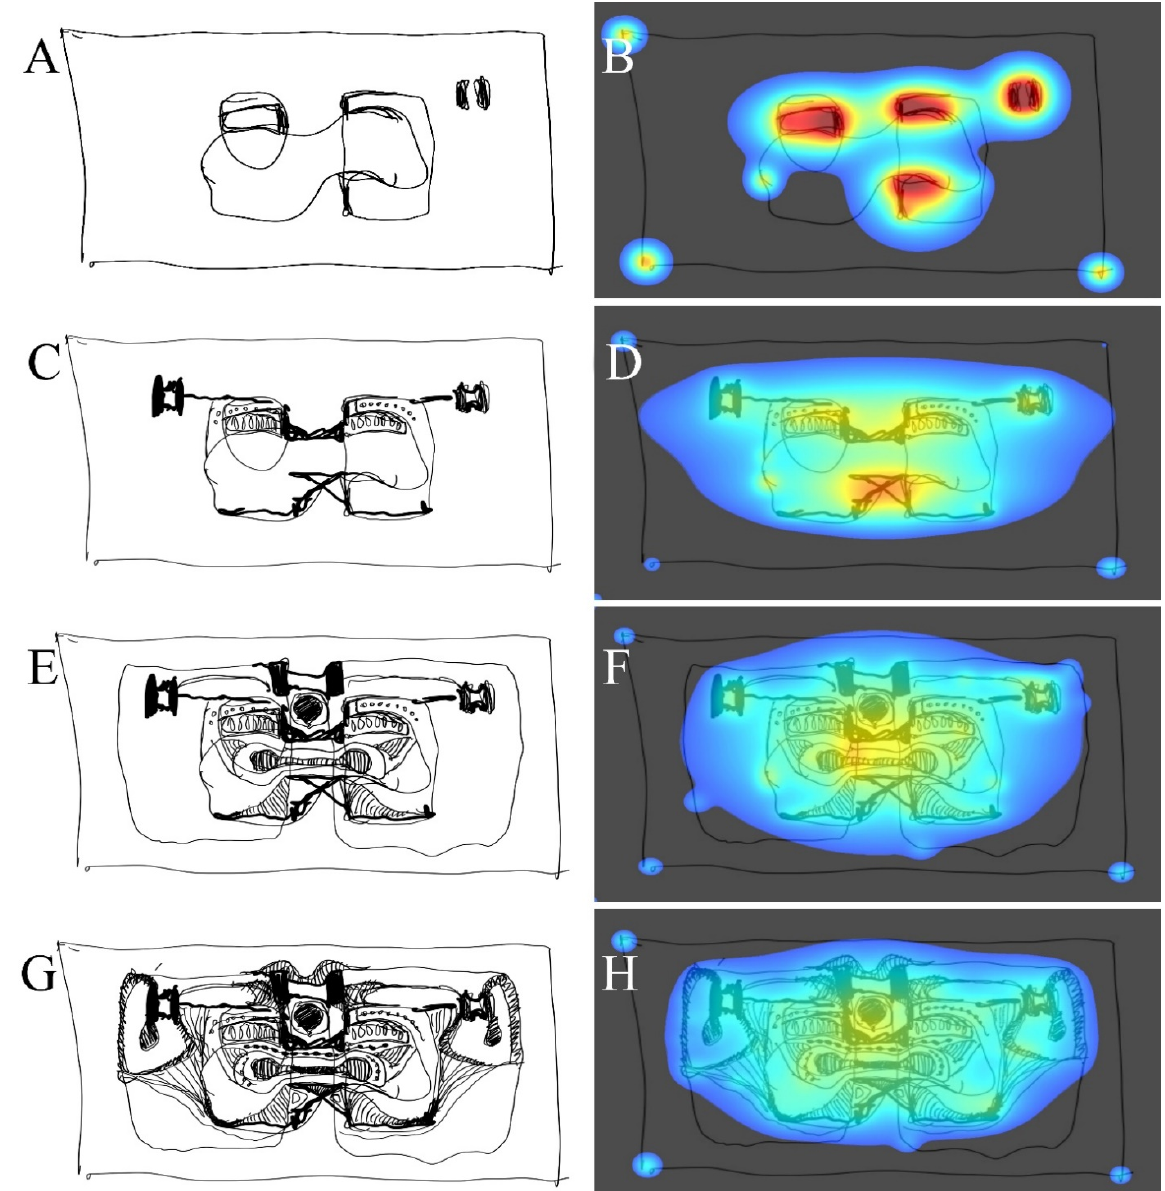
Figure 12. A sequence of drawings with contrast, detail, and local symmetries increasing dramatically. Sequence ( A , C , E , G ) fills out a drawing with increasing detail and approximate, overlapping symmetries. Sequence ( B , D , F , H ) represents the corresponding eye-tracking simulation heatmaps, which lose their hotspots as they become more and more uniformly coherent.